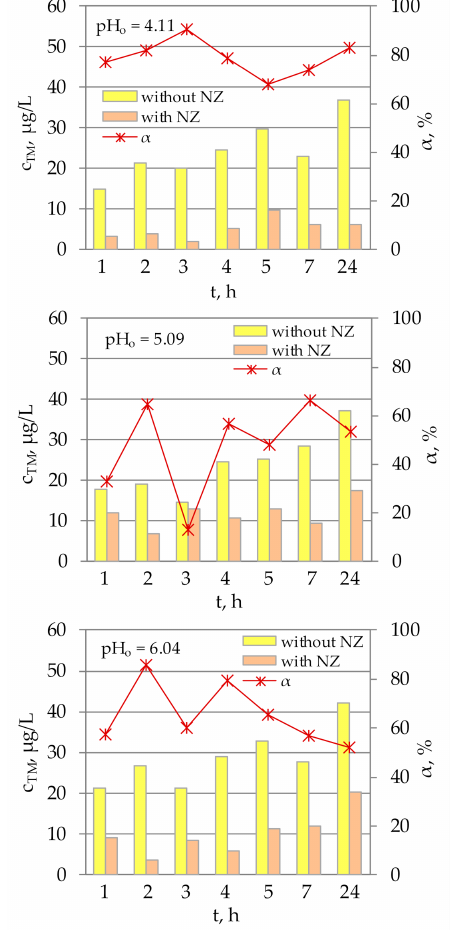
Figure 16. The concentration of total mercury leached from the soil and removal efficiency of natural zeolite at time intervals within 24 h without and with the addition of natural zeolite for three different pH o values of ultrapure